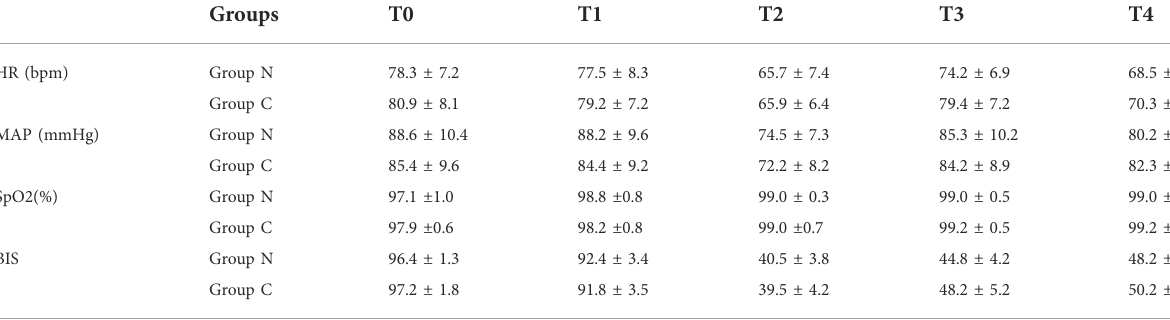
TABLE 3 Comparison of MAP, HR, SpO 2 and BIS values at different time points between the two groups ( n = 186).